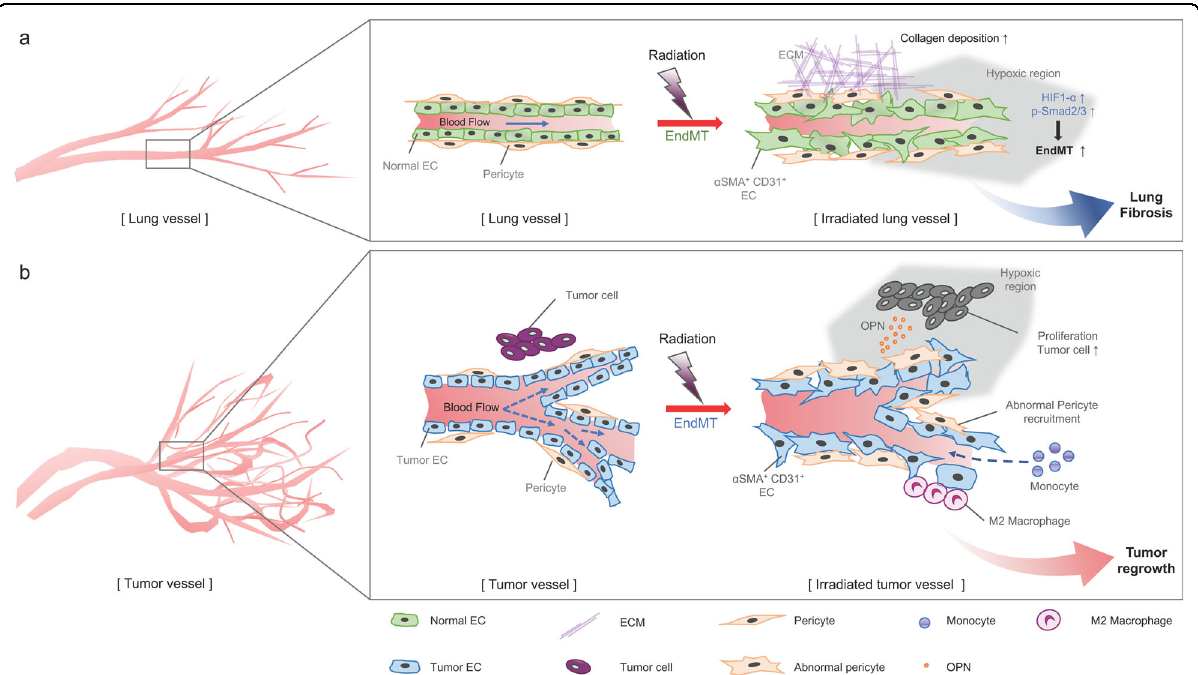
Fig. 1 Schematic illustration of the effects of tumor EndMT on the tumor microenvironment. Mesenchymal transition of tumor ECs results in CAF formation and an abnormal tumor vasculature. a CAFs can affect tumor resistance to chemotherapy. b Fibrotic changes in ECs cause the loss of EC-speci fi c characteristics with downregulated VEGF receptor expression, which can cause resistance to anti-VEGF therapy. c Immune cell in fi ltration into the tumor microenvironment after chemotherapy and radiation therapy can promote the generation of more protumor-immune cells via EndMT, resulting in a fi brotic vascular